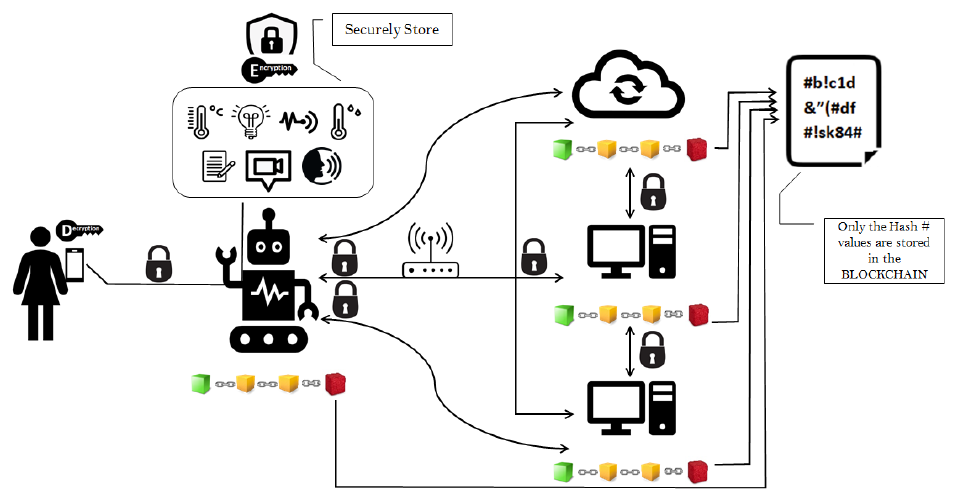
Figure 2. Proposed Resource Aware Private Blockchain Network.